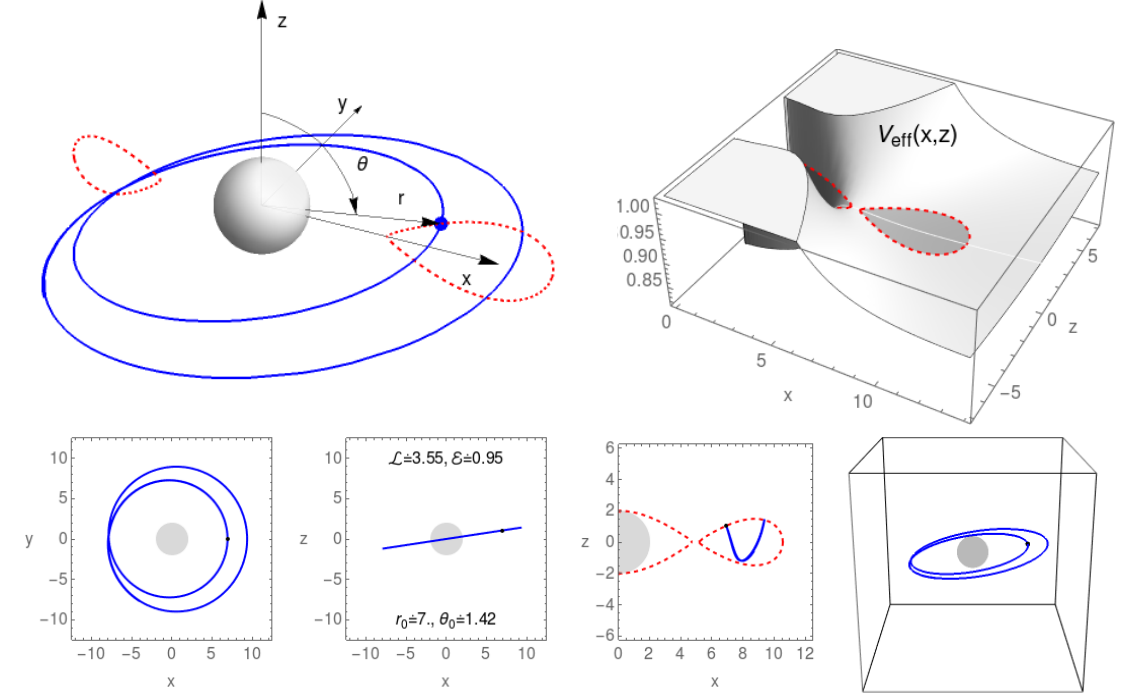
Figure 2. Charged particle on bounded orbit around BH with uniform magnetic filed. Full 3D charged particle trajectory (left figure first row) and representation of its dynamics in effective potential (right figure fist row). Second row of figures show different view on the same particle particle trajectory but from diferent